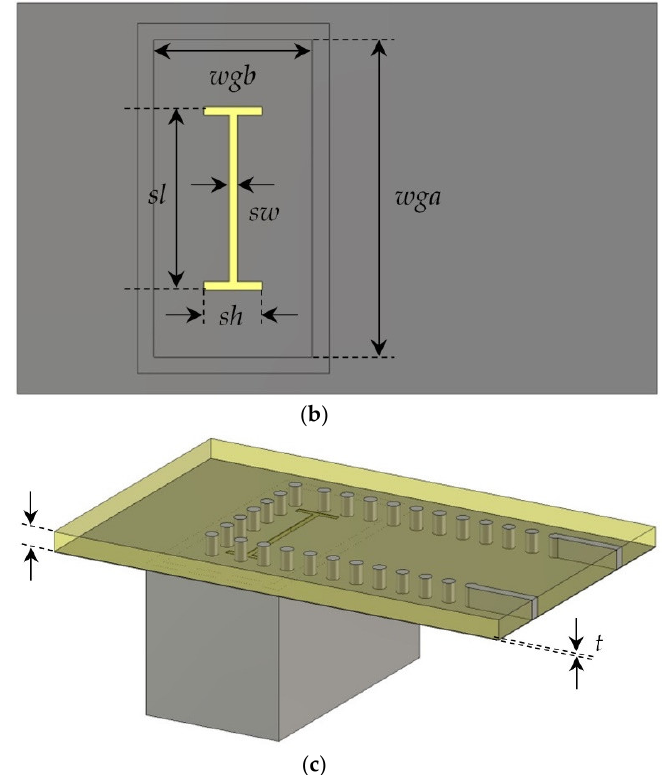
Figure 1. RWG-to-SIW transition geometry with no matching elements. ( a ) Top view; ( b ) Bottom view; ( c ) 3D view.